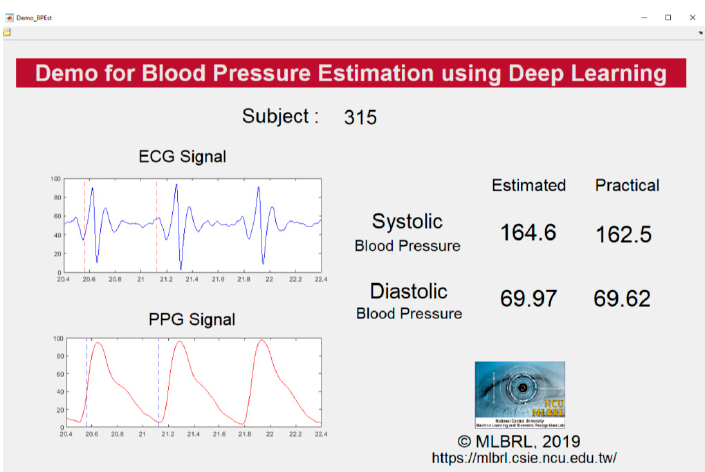
Figure 10. Our real-time demonstration